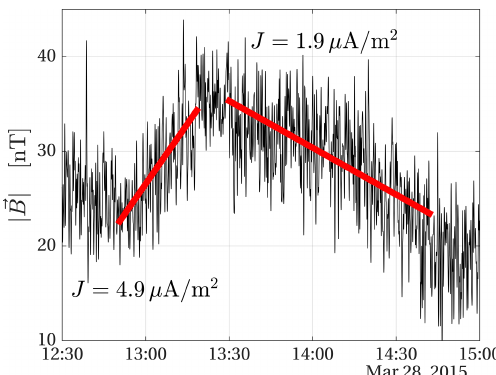
Figure 5. Magnetic field magnitude during a period around closest approach. The red lines are fitted to the data in order to derive the current densities J = 4 . 9µAm − 2 (inbound) and J = 1 . 9µAm − 2